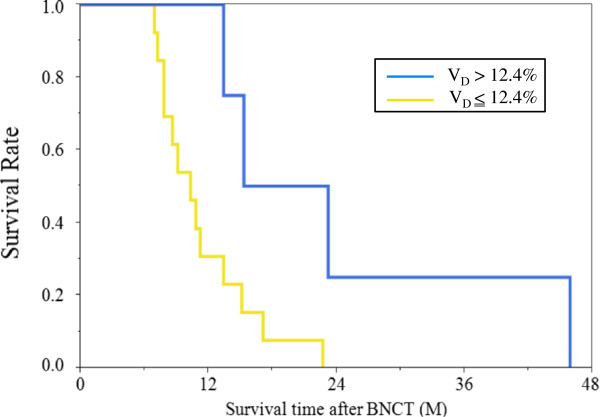
Survival analysis of VD at 2 days after BNCT: VD greater than 12.4% at 2 days after BNCT was good response for BNCT (median survival = 19.3 months; 95% CI = 13.4 - 45.9 months) and VD 12.4% or less at 2 days after BNCT was nonresponse for BNCT (median survival = 10.3 months; 95% CI = 7.8 - 13.4 months).